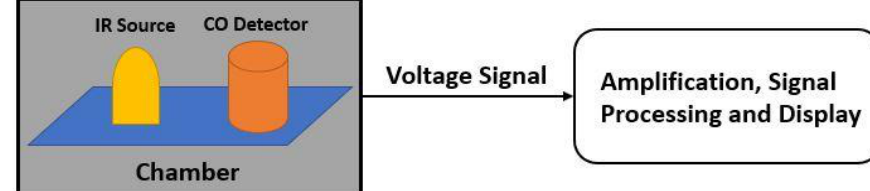
Figure 25. Non-dispersive infrared (NDIR) based CO detection system.